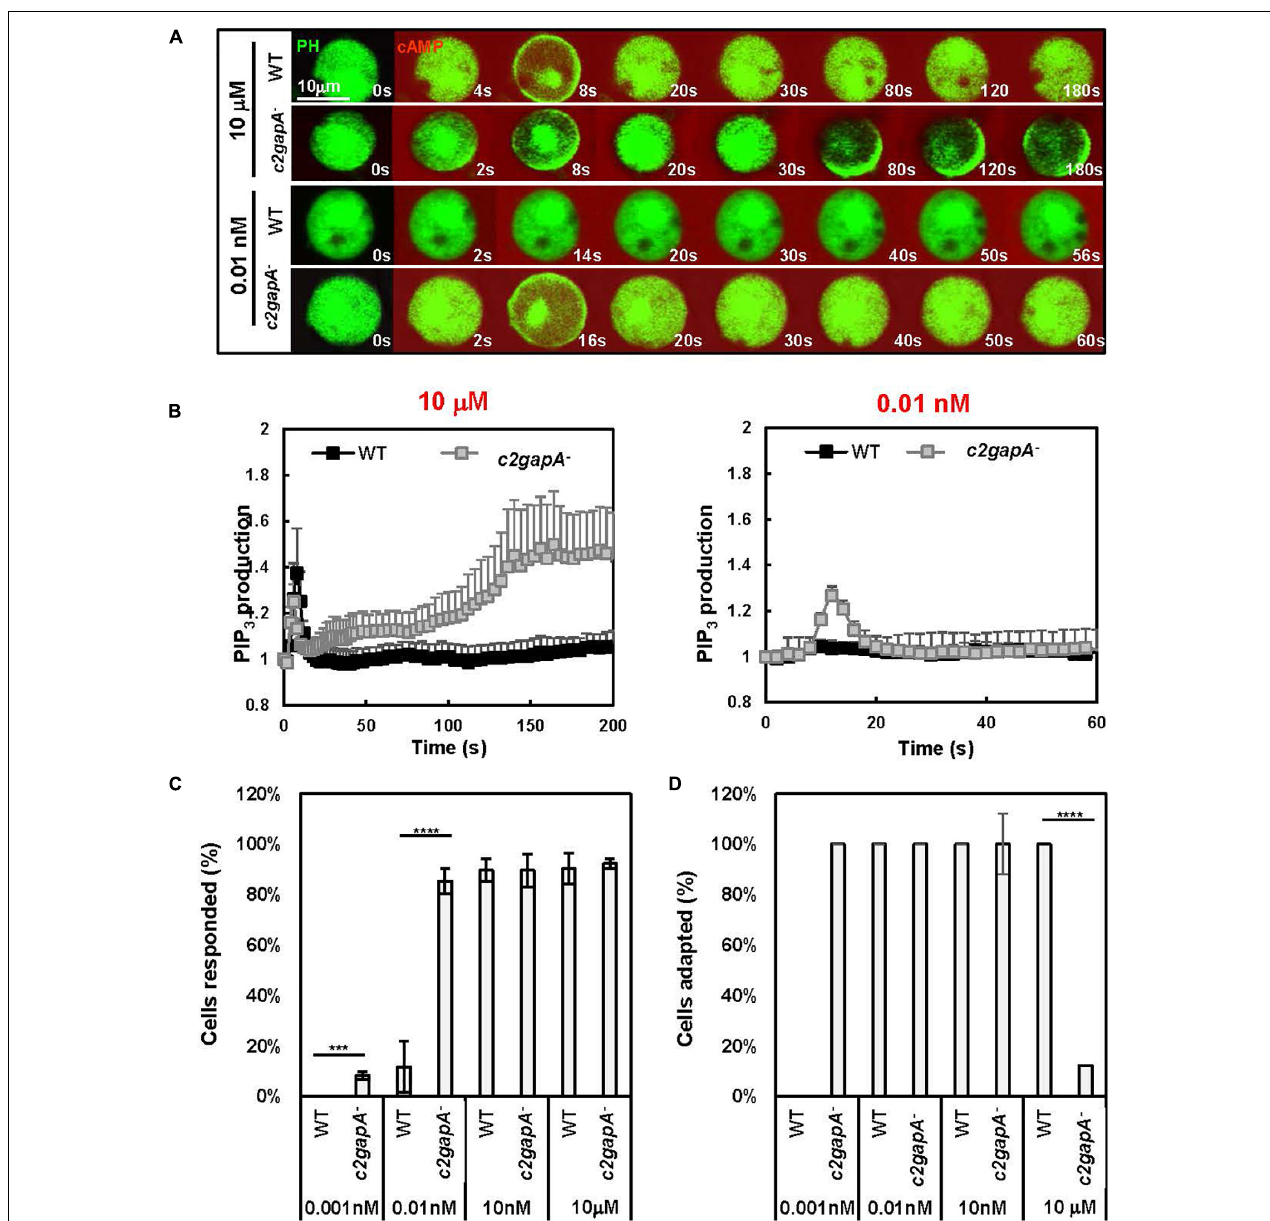
FIGURE 3 | c2gapA − cells are more sensitive to the stimuli at low concentrations and fail to adapt to the stimuli at high concentrations. (A) Montage shows cell response as PIP 3 production monitored through the membrane translocation of the PIP 3 probe PH Crac -GFP, in WT or c2gapA − cells. Cells were stimulated with either 0.01 nM or 10 µ M Sp-cAMPS, respectively. Also see Supplementary Videos 3, 4 for cell response to 10 µ M or 0.01 nM Sp-cAMPS stimulation, respectively. (B) Quantitative measurement of PIP3 production in WT and c2gapA − in response to 10 µ M or 0.01 nM Sp-cAMP stimulation shown in (C) . PIP3 production was quantified by the decrease in the cytosolic intensity of PH Crac -GFP. The cytosolic intensity at time 0 s was normalized to 1. Mean ± SD is shown; n = 8 and 12, or 8 and 11 for WT, c2gapA − cells in response to 10 µ M or 0.01 nM Sp-cAMPS stimulation, respectively. (C) Percentage (%) of cells displaying response to 0.001 nM,0.01 nM, 10 nM, and 10 µ M Sp-cAMPS stimulation in WT and c2gapA − cells, respectively. The same three independent experiments were used to calculate for (C,D) . Student’s t -test was used to calculate the p -value, which is indicated as *** ( p < 0.001) and **** ( p < 0.0001). (D) Percentage (%) of cells failing to display adaptation to 0.001, 0.01, 10 nM, and 10 µ M cAMP stimulation in WT and c2gapA − cells.